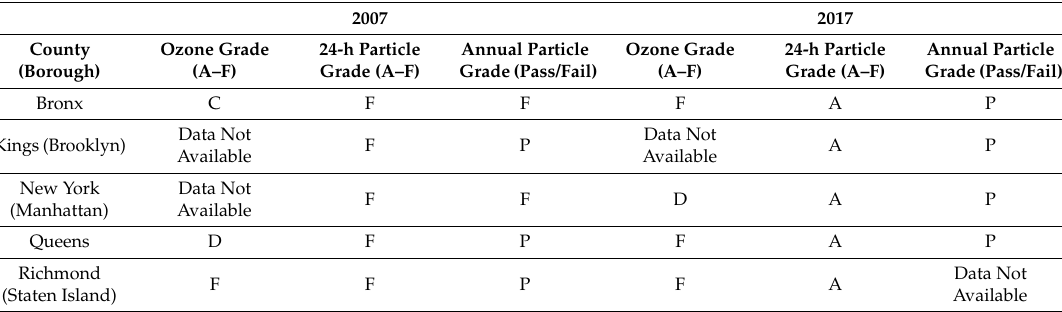
Table 1. New York City Air Quality Scores (2007 and